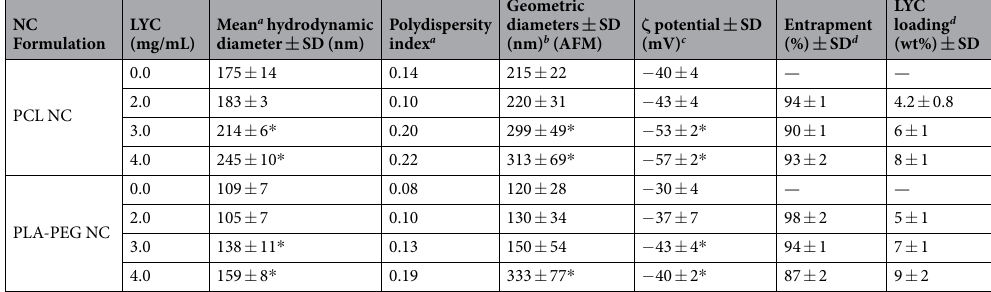
Table 1. Physicochemical characterization of lychnopholide nanocapsules. a Mean of three measurements of three nanocapsule batches. Samples with values lower than 0.3 were considered monodispersed in size. b Geometric diameters were measured on the height atomic force microscopy (AFM) images considering the width of the spheres at half height reported as the average of 60 particles and standard deviation. c Measurement after dilution at 1:1000 in 1 mM NaCl ( n = 3 batches). d Determined by ultrafiltration/centrifugation method and assayed by HPLC following calculation described in the methods section. * Indicates significant differences compared to blank (no LYC) nanocapsules ( p ≤